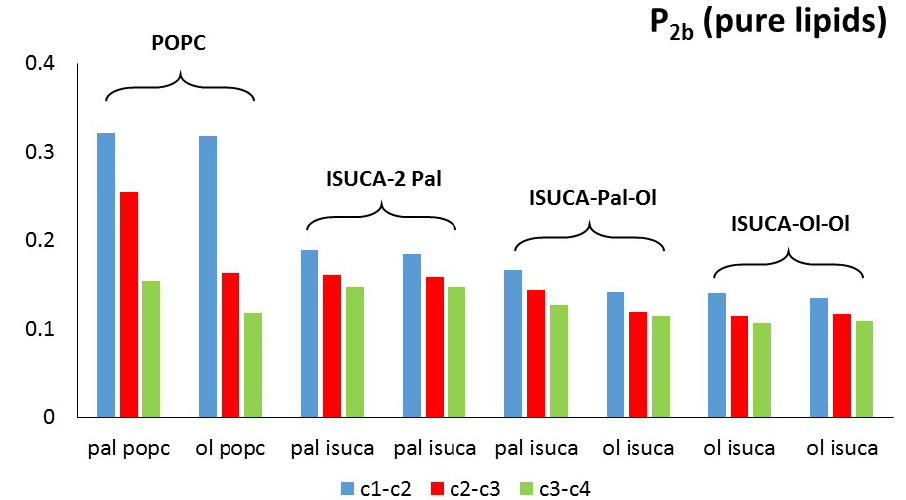
Figure 5. P 2b for pure lipids: pal = palmitic hydrocarbon chain, ol = oleic hydrocarbon chain.